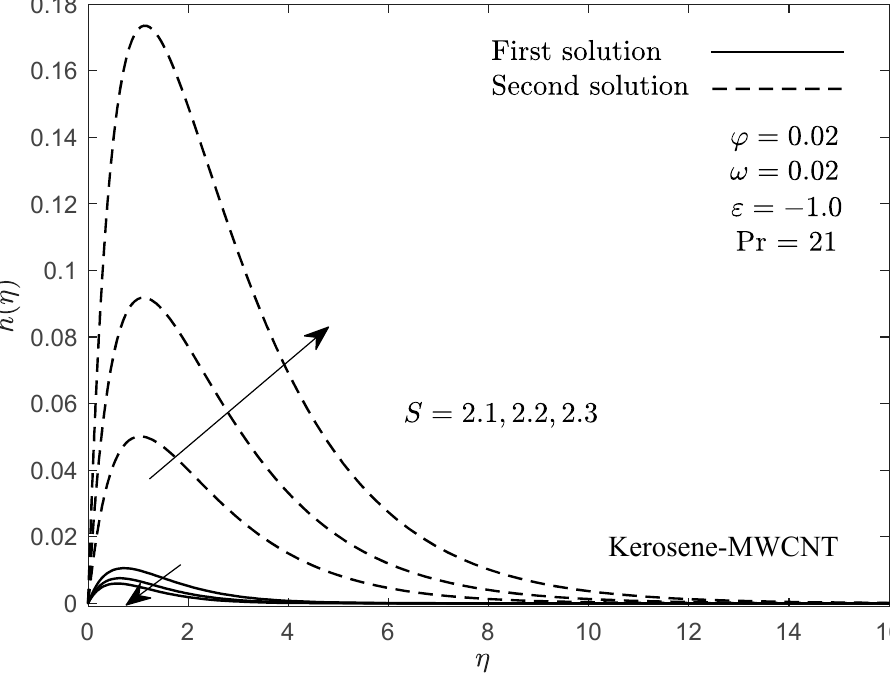
Figure 13. Velocity profiles of y -component h ( η ) for some values of S .